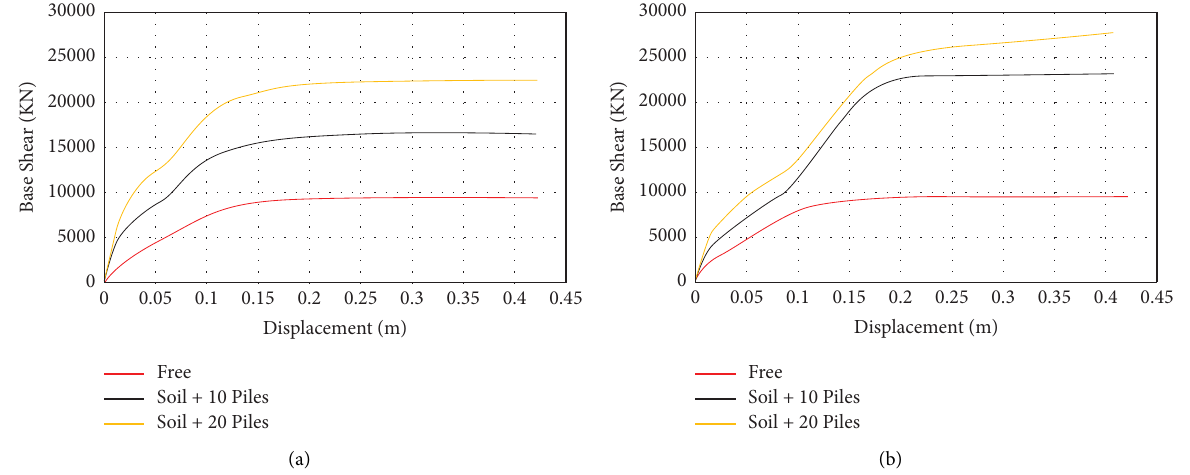
Figure 11: Pushover curves of F3, L3, and H3 bridge models in (a) longitudinal and (b) transverse